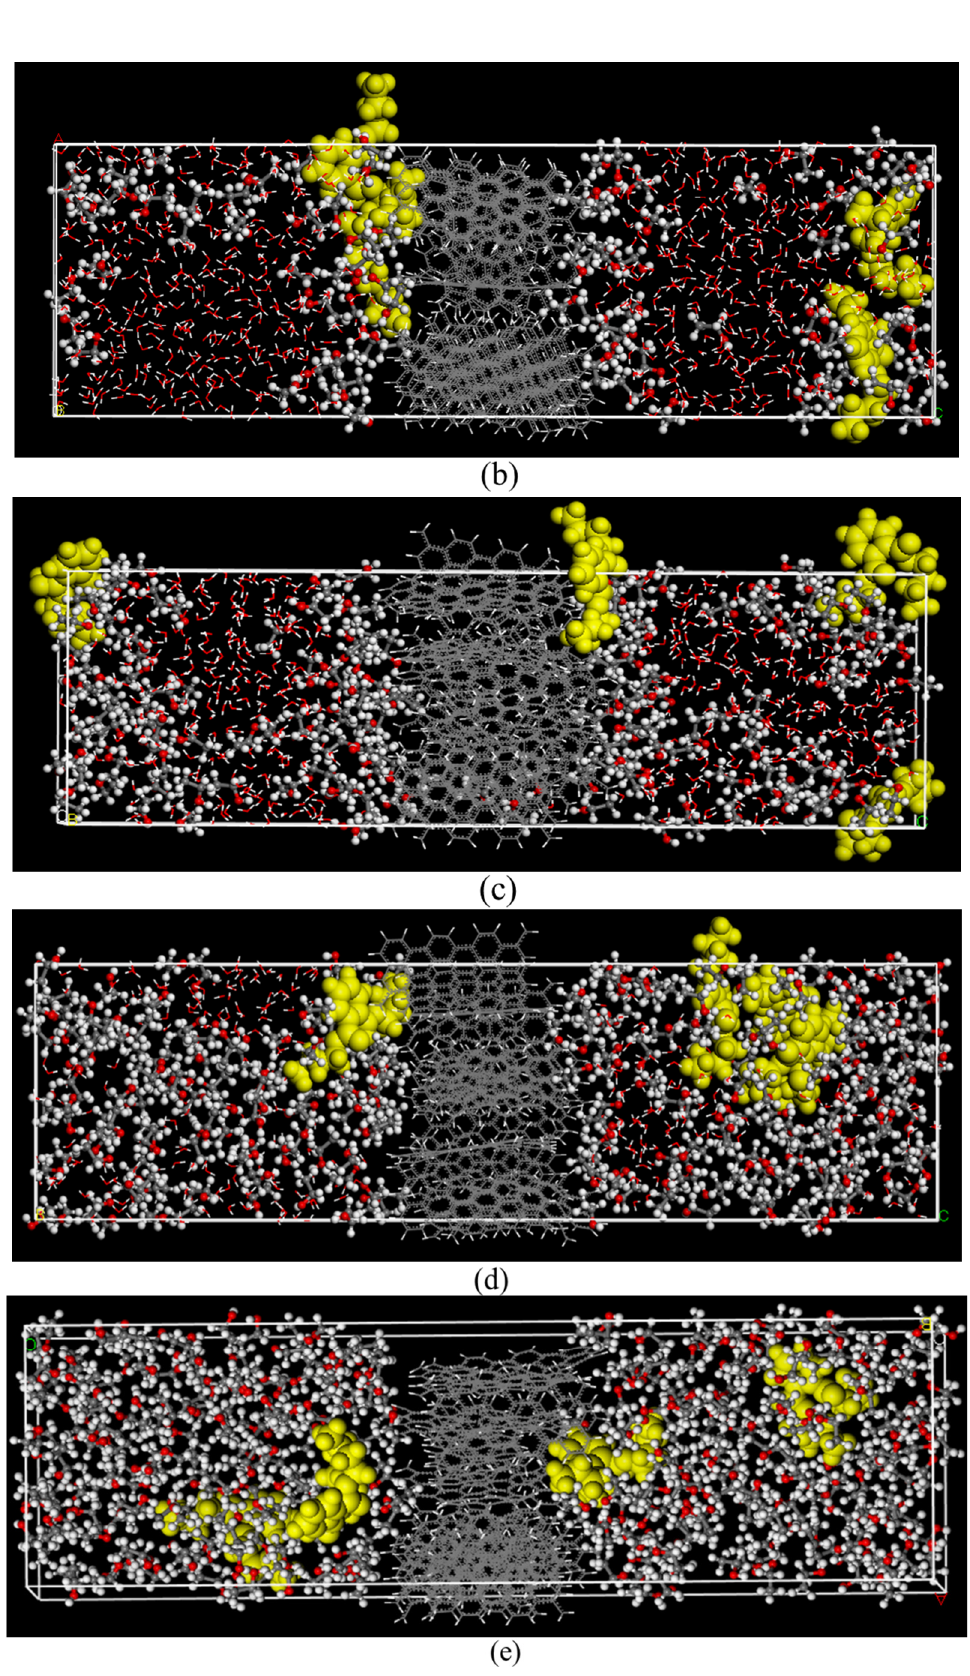
Figure 6. Model snapshots of solutions with different ethanol contents: ( a ) 0 v%; ( b ) 30 v%; ( c ) 50 v%; ( d ) 70 v%; ( e ) 100 v%.